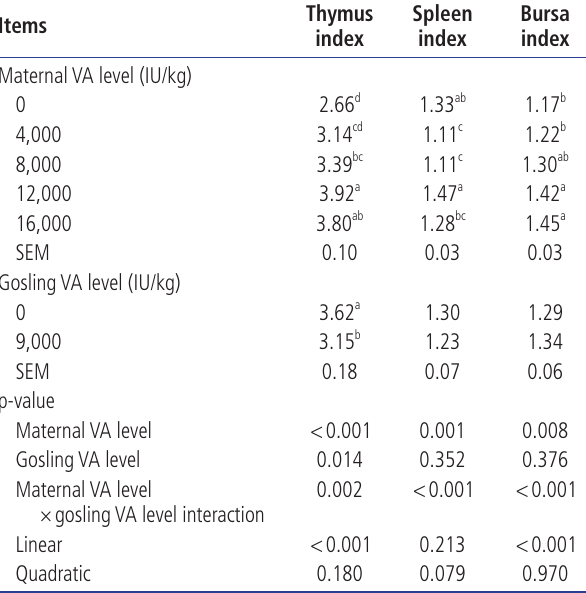
Table 6. Effects of different vitamin A levels of maternal and offspring diets on immunoglobulin content of offspring in serum